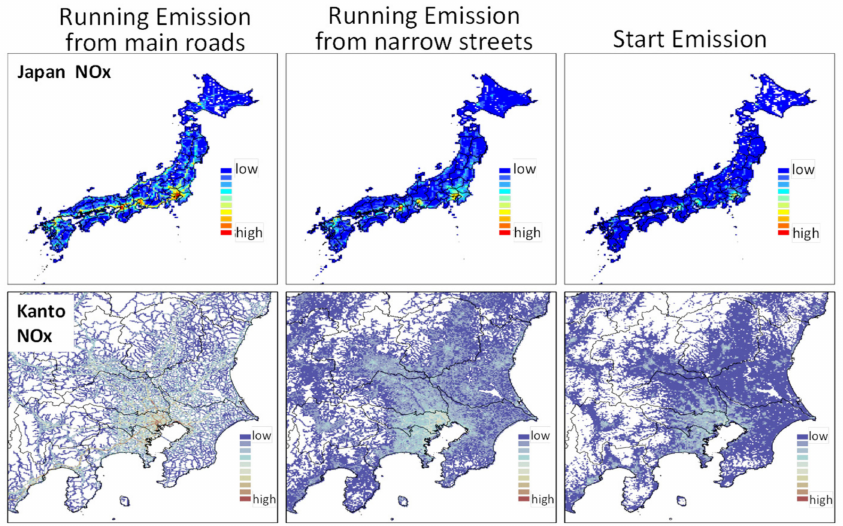
Figure 6. Example of automobile emission results by the JATOP Emission Inventory-Vehicle Emission Model